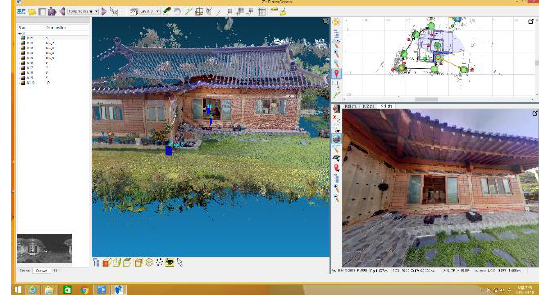
Figure 9. 3D model of building inside generated at